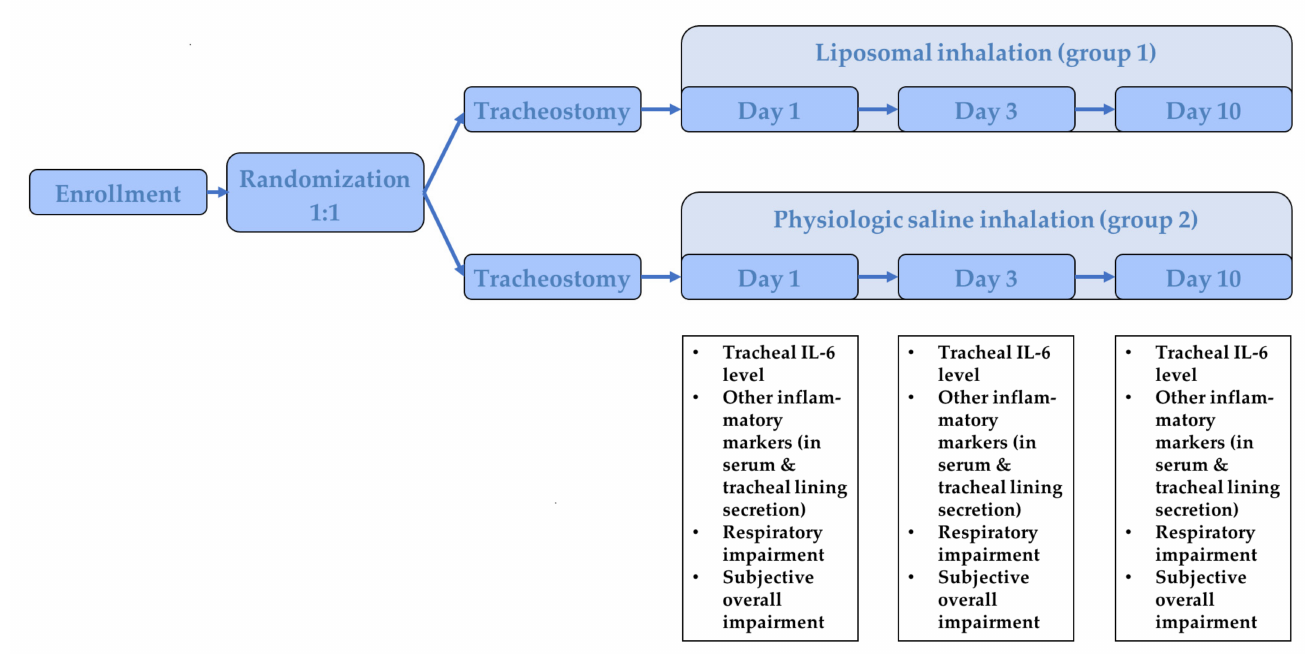
Figure 1. Illustration of the study